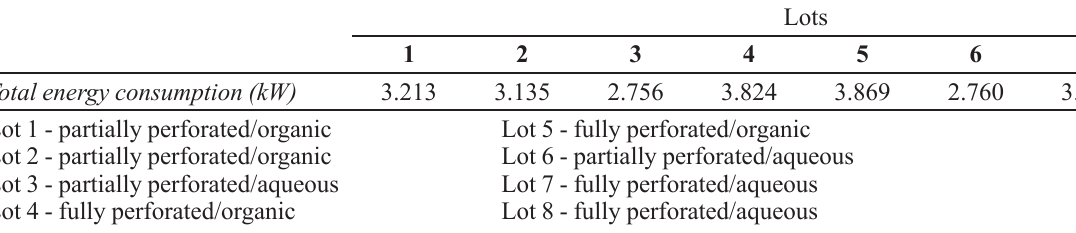
TABLE V - Total energy consumption for lots 1-8 during core coating